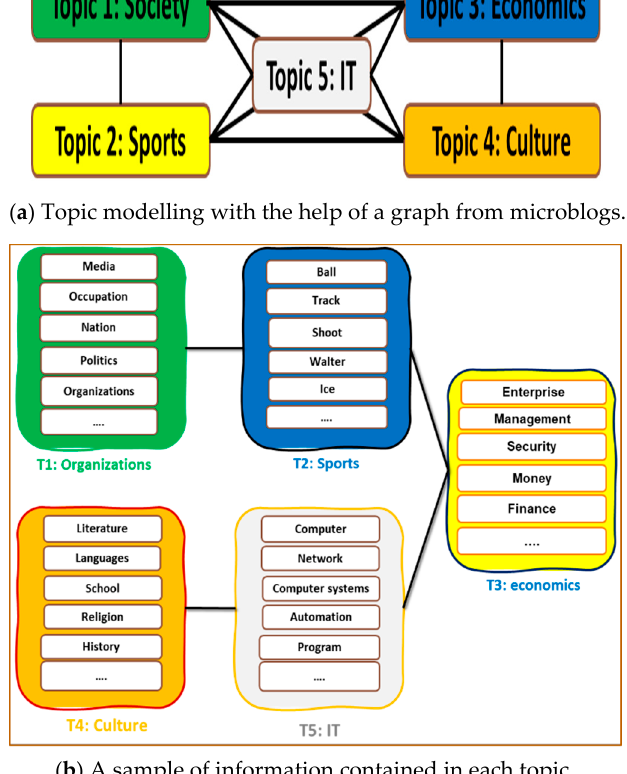
Figure 34. Overview of topic modelling and information contained in each topic by leveraging graphs.